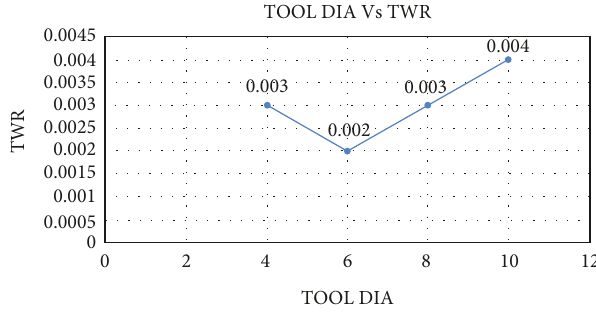
Figure 6: Tool DIA versus MRR.